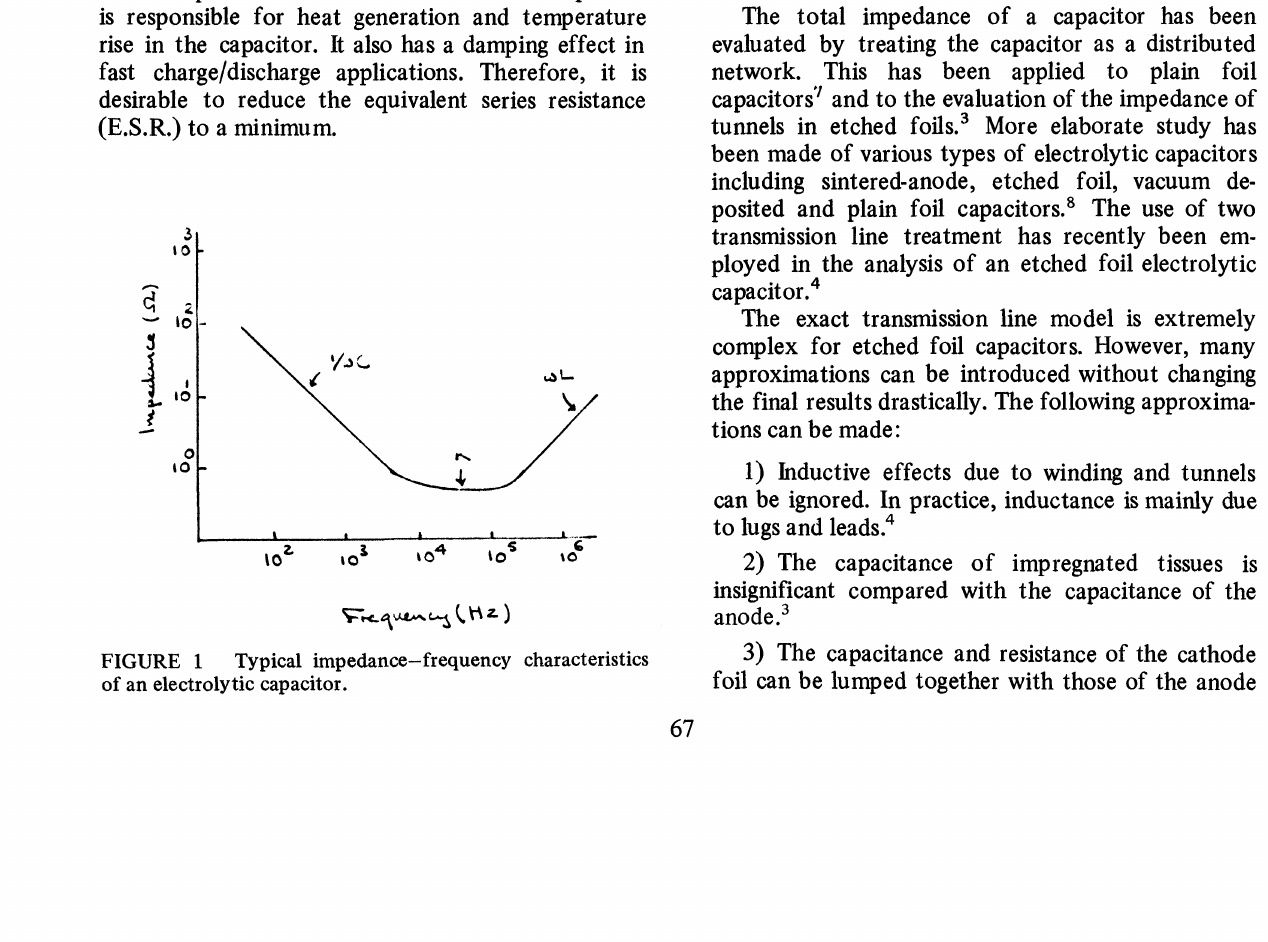
FIGURE 1 Typical impedance-frequency characteristics of an electrolytic